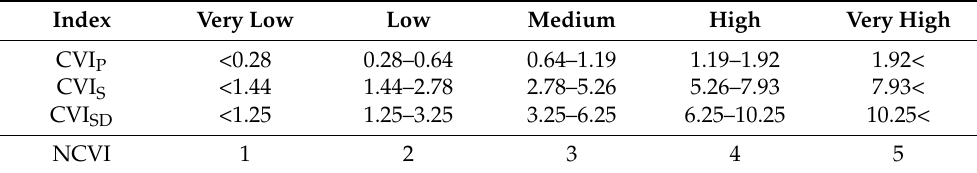
Table 10. Normalized Costal Vulnerability Index (NCVI) according to parameter